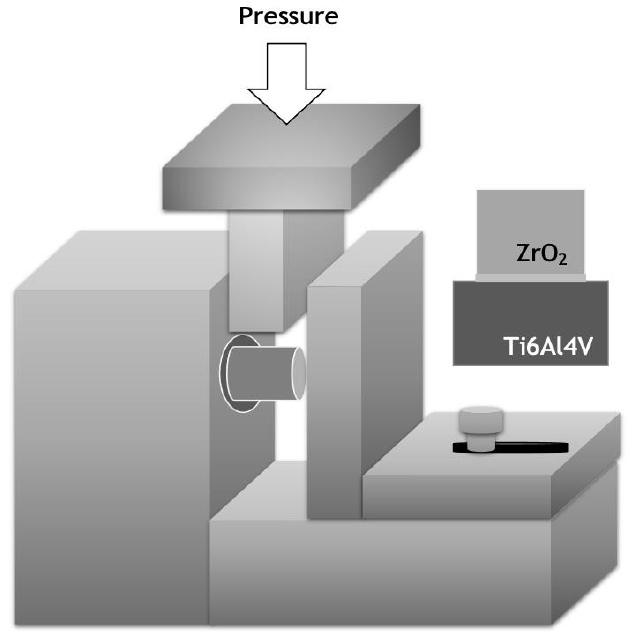
Figure 2. Schematic illustration of the shear strength test apparatus used.